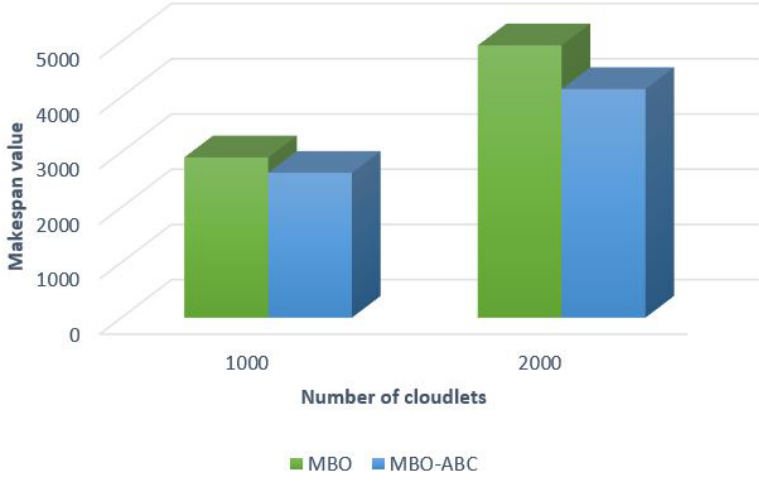
Figure 13. Comparative analysis—MBO-ABC vs. MBO using HPC2N real trace for a large number of